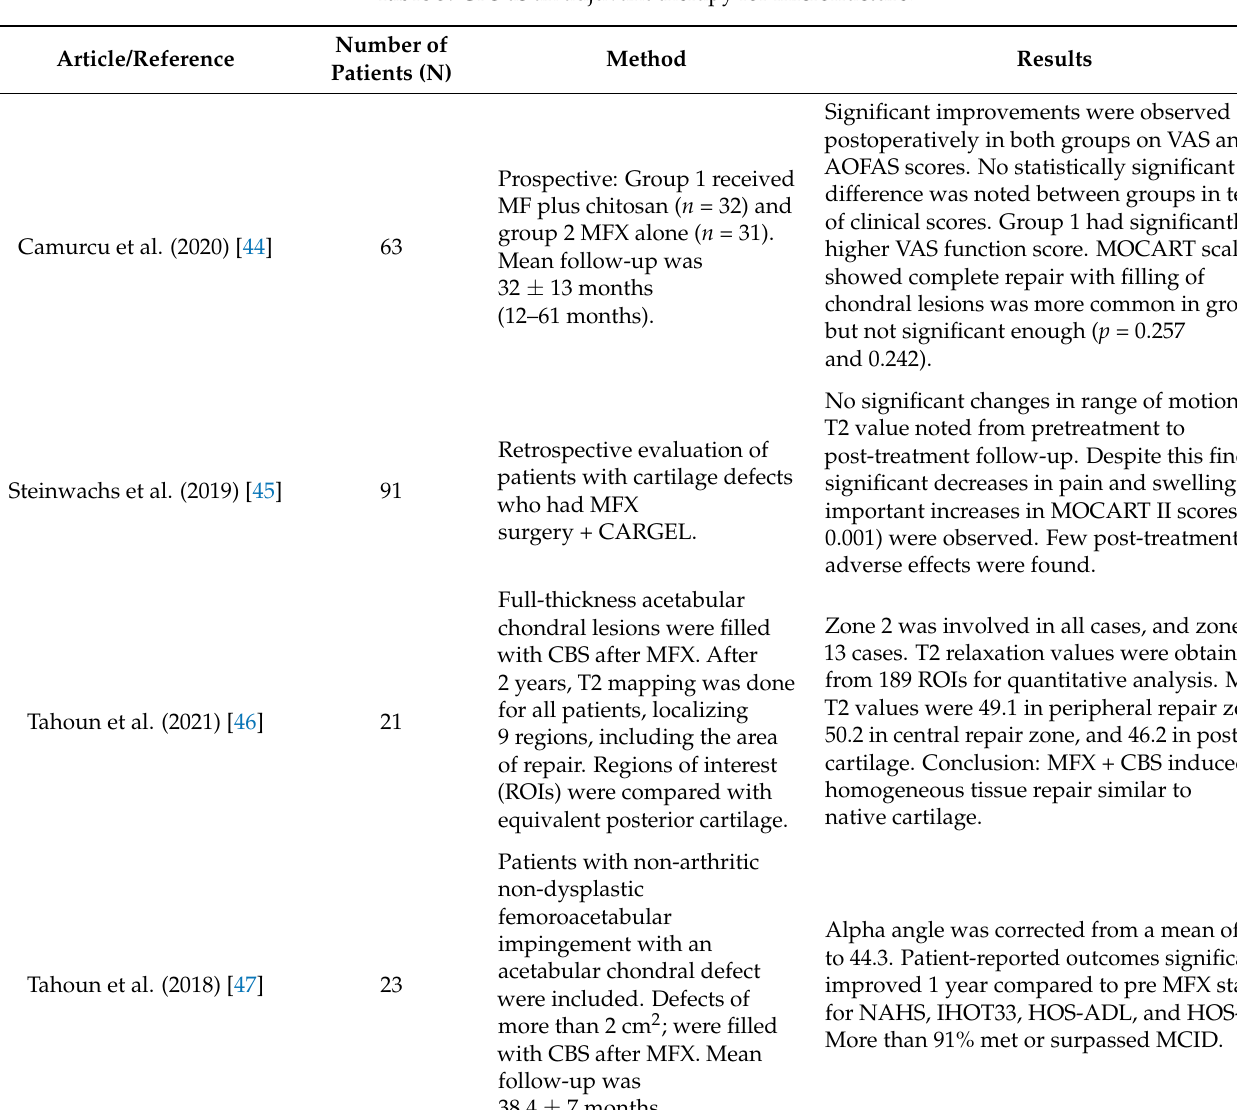
Table 3. CBS as an adjuvant therapy for